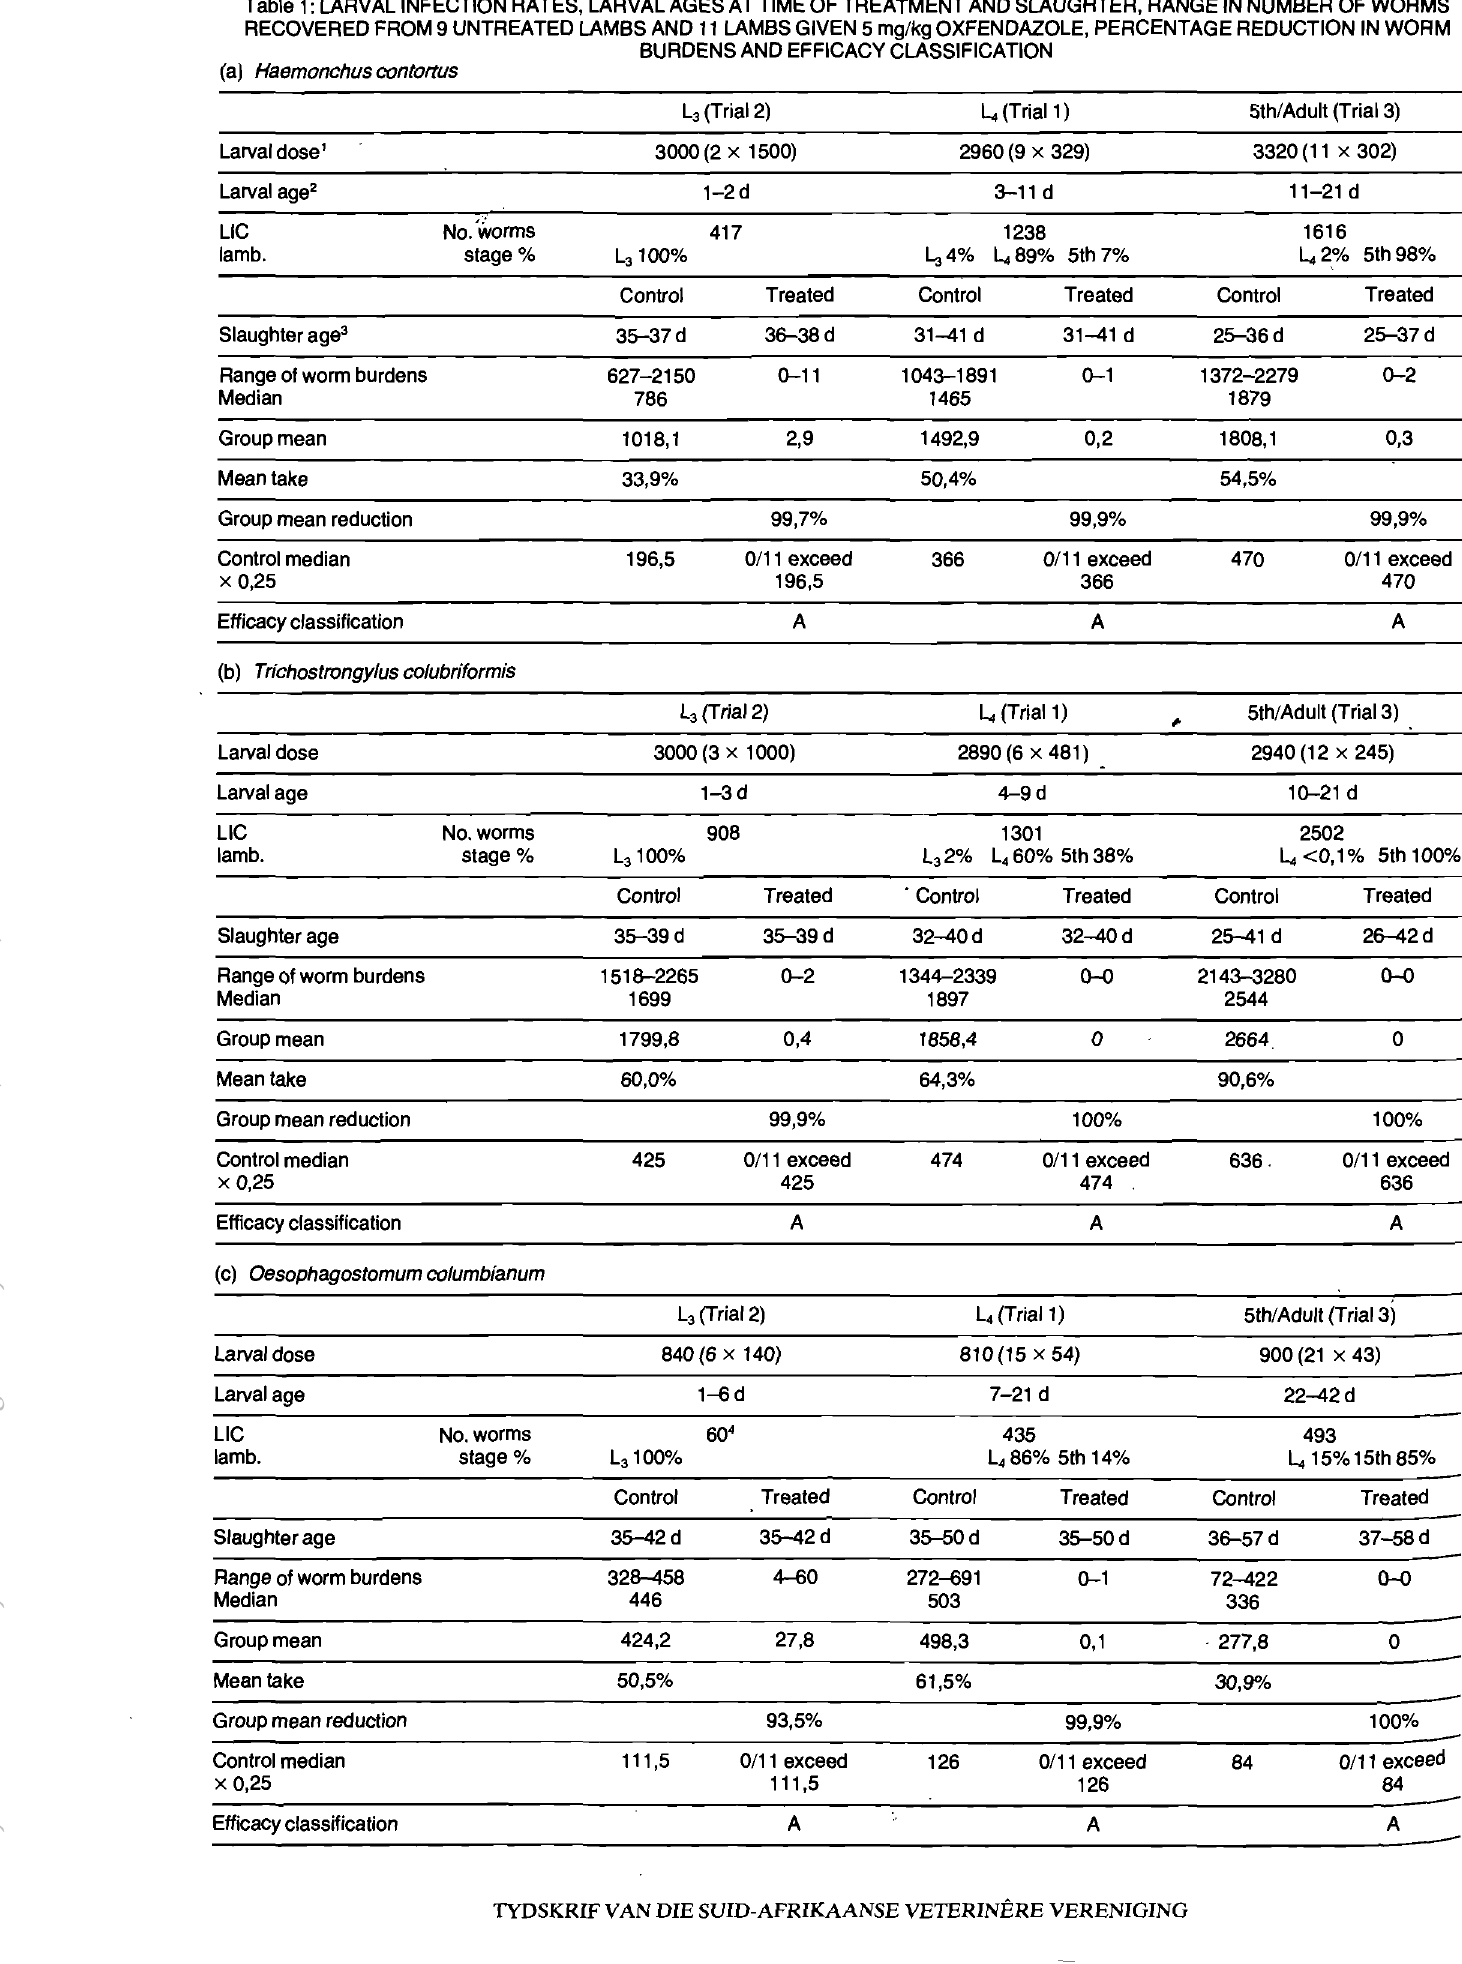
Table 1: LARVAL INFECTION RATES, LARVAL AGES AT TIME OF TREATMENT AND SLAUGHTER, RANGE IN NUMBER OF WORMS RECOVERED FROM 9 UNTREATED LAMBS AND 11 LAMBS GIVEN 5 mg/kg OXFENDAZOLE, PERCENTAGE REDUCTION IN WORM BURDENS AND EFFICACY CLASSIFICATION (a) Haemonchus